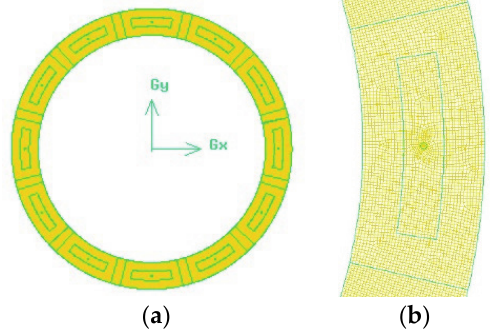
Figure 4. Oil film fluid domain mesh. ( a ) Fluid domain mesh, ( b ) Local magnification diagram.